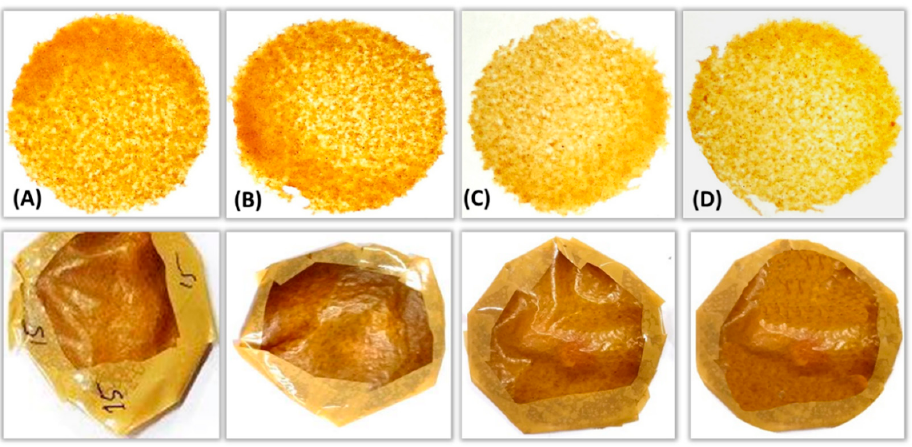
Figure 2. Images of sweet lime peel residue-based film (Film ( A )—0% EO, Film ( B )—1% EO, Film ( C )—2% EO, Film ( D )—3% EO) and packaged fish fillets. ( C )—2% EO, Film ( D )—3% EO) and packaged fish